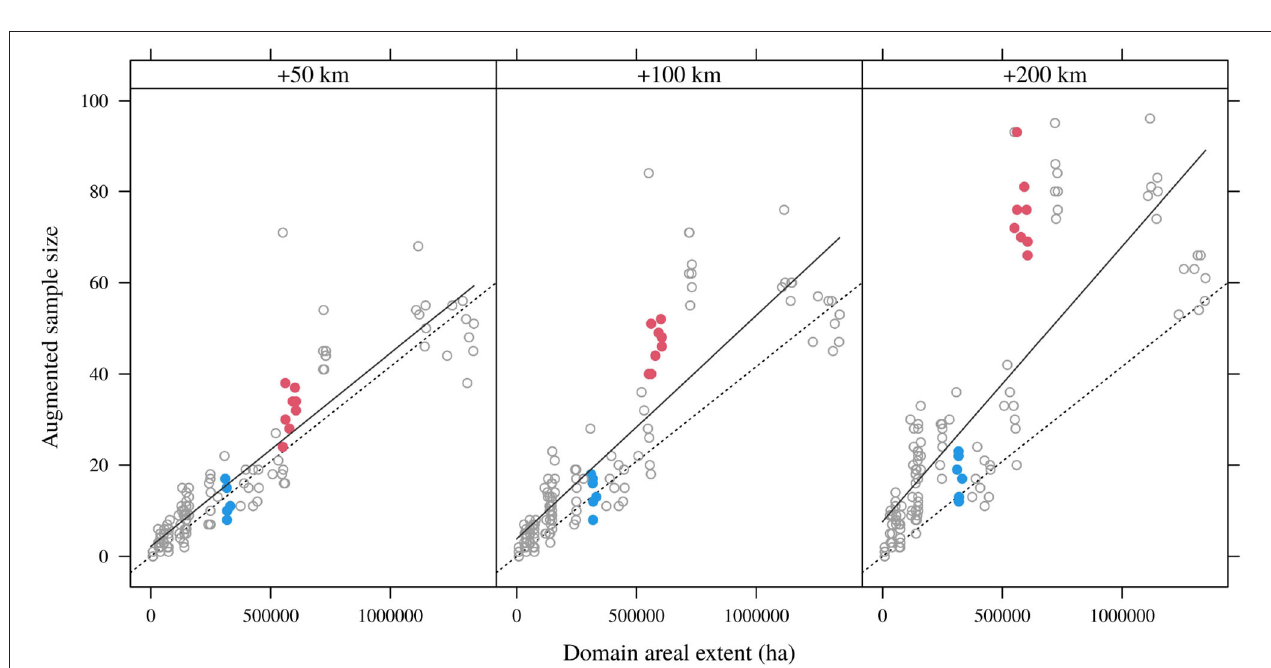
FIGURE 4 | Augmented sample sizes and domain areas for 10-year domains (all lags) and different spatial buffers (50, 100, and 200 km). Dotted line is the nominal FIA sampling intensity; solid lines are linear regressions for particular spatial buffers.